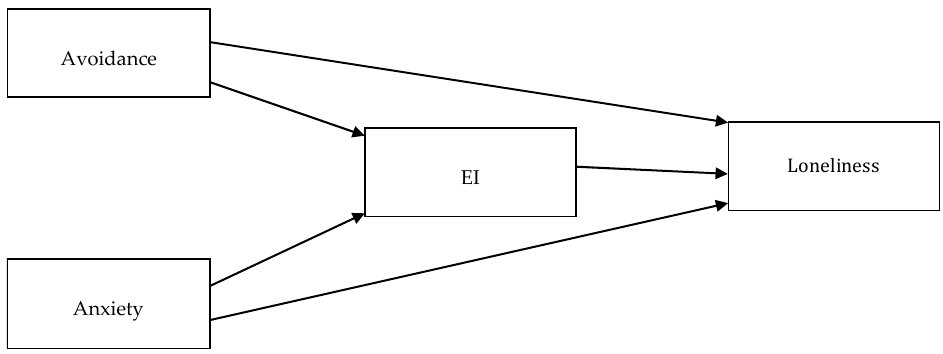
Figure 1. Mediation model with two independent variables and a simple mediator, tested in Study 1.